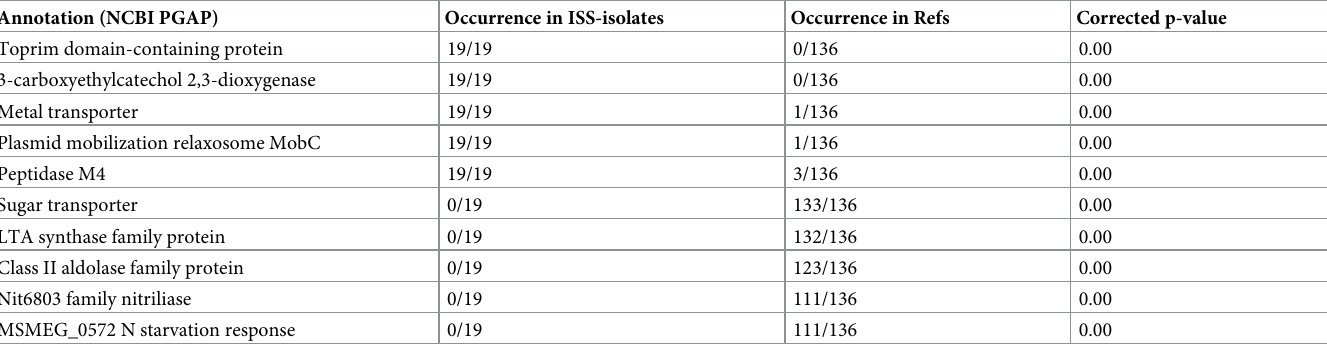
Table 3. ISS-derived B . cepacia enriched/depleted functions as compared to